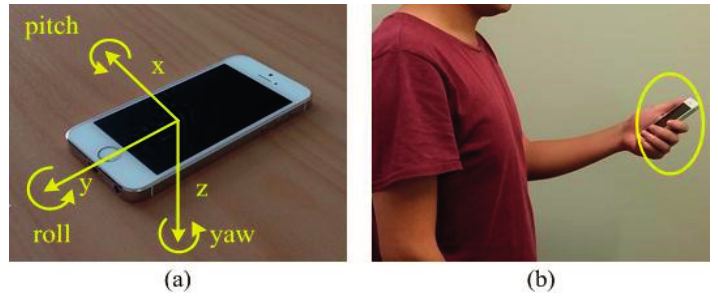
Figure 2. ( a ) Phone axis definition ( b ) Phone